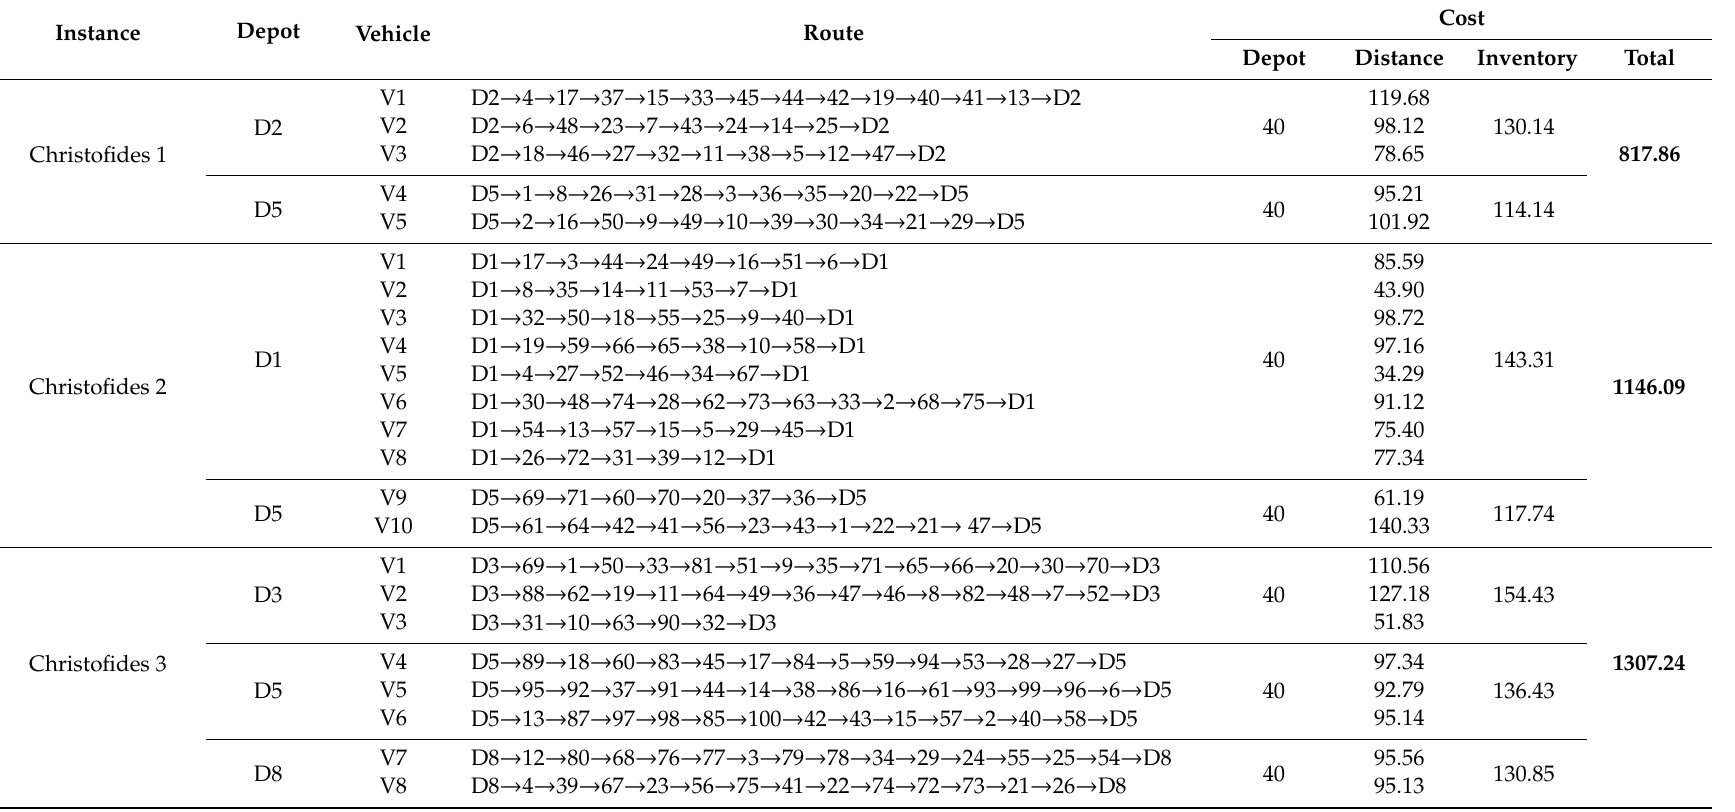
Table 11. Distribution of routes and costs for Christofides dataset generated by HS-SA for LIRP. Instance Depot Vehicle Route